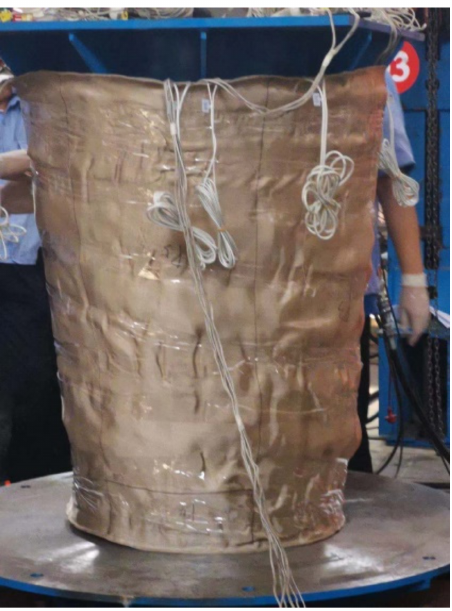
Figure 17. Mechanical properties test on the conical shell